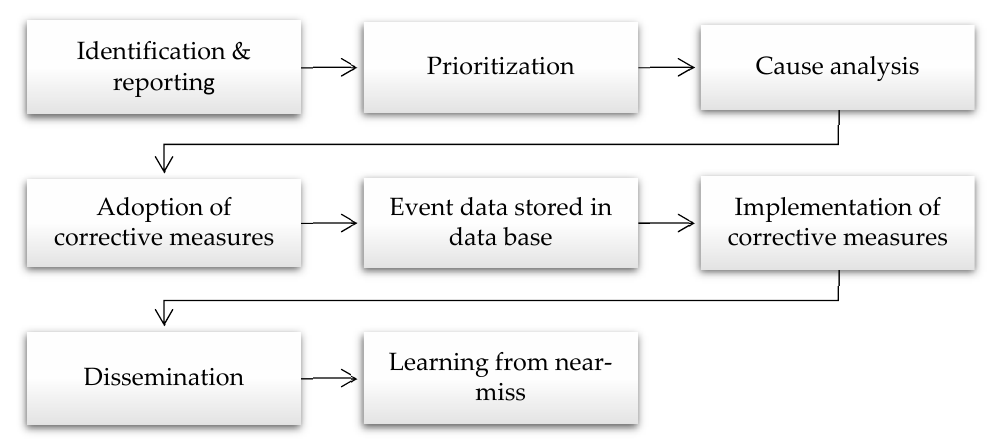
Figure 1. Near-miss management system in shipping.